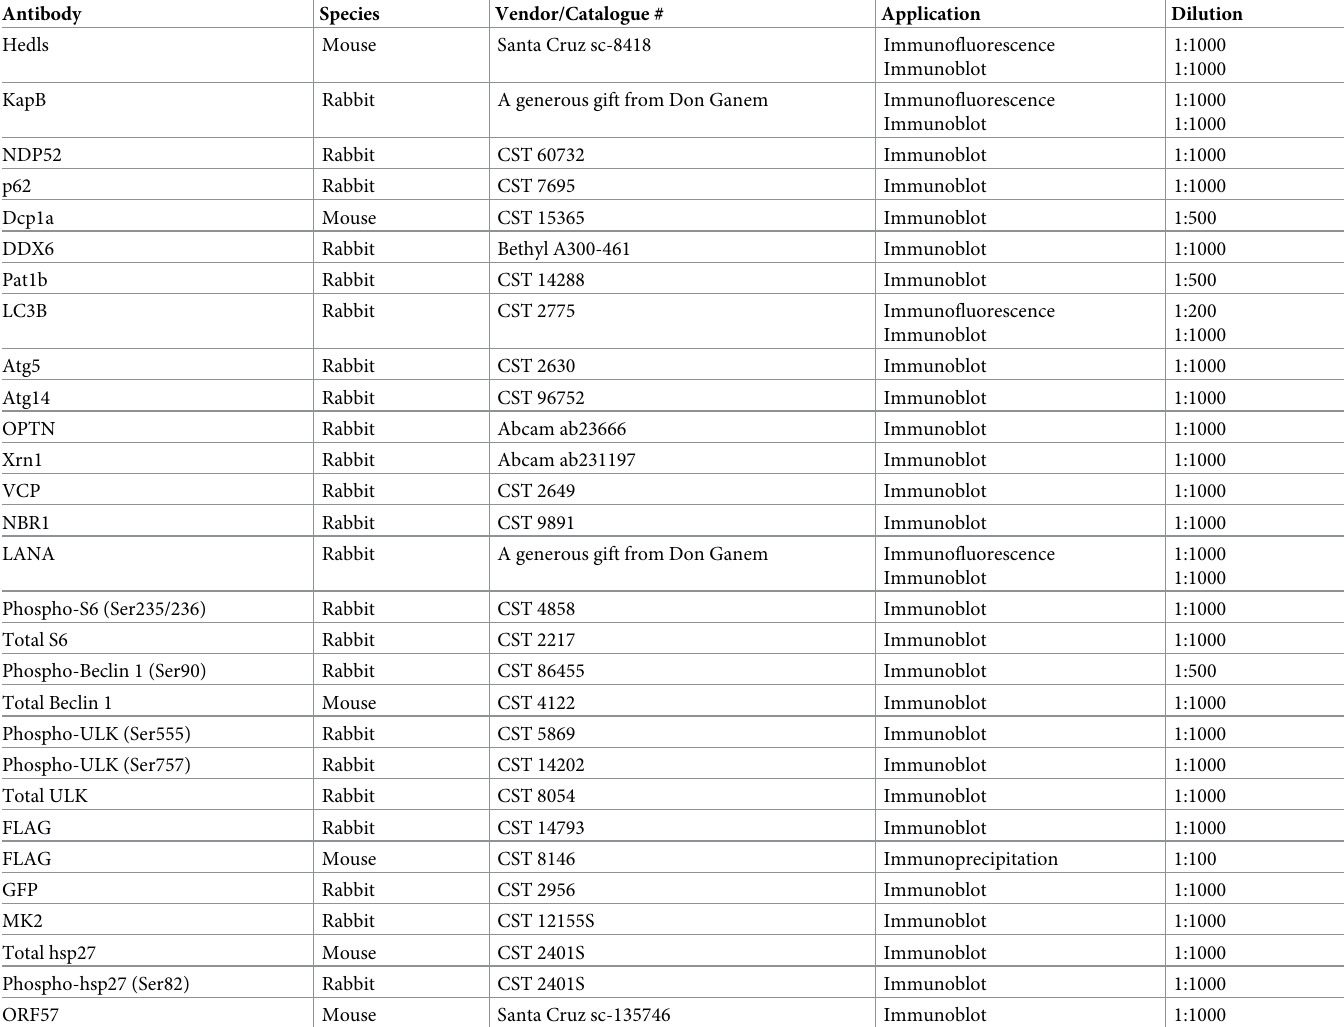
Table 5. Antibodies.